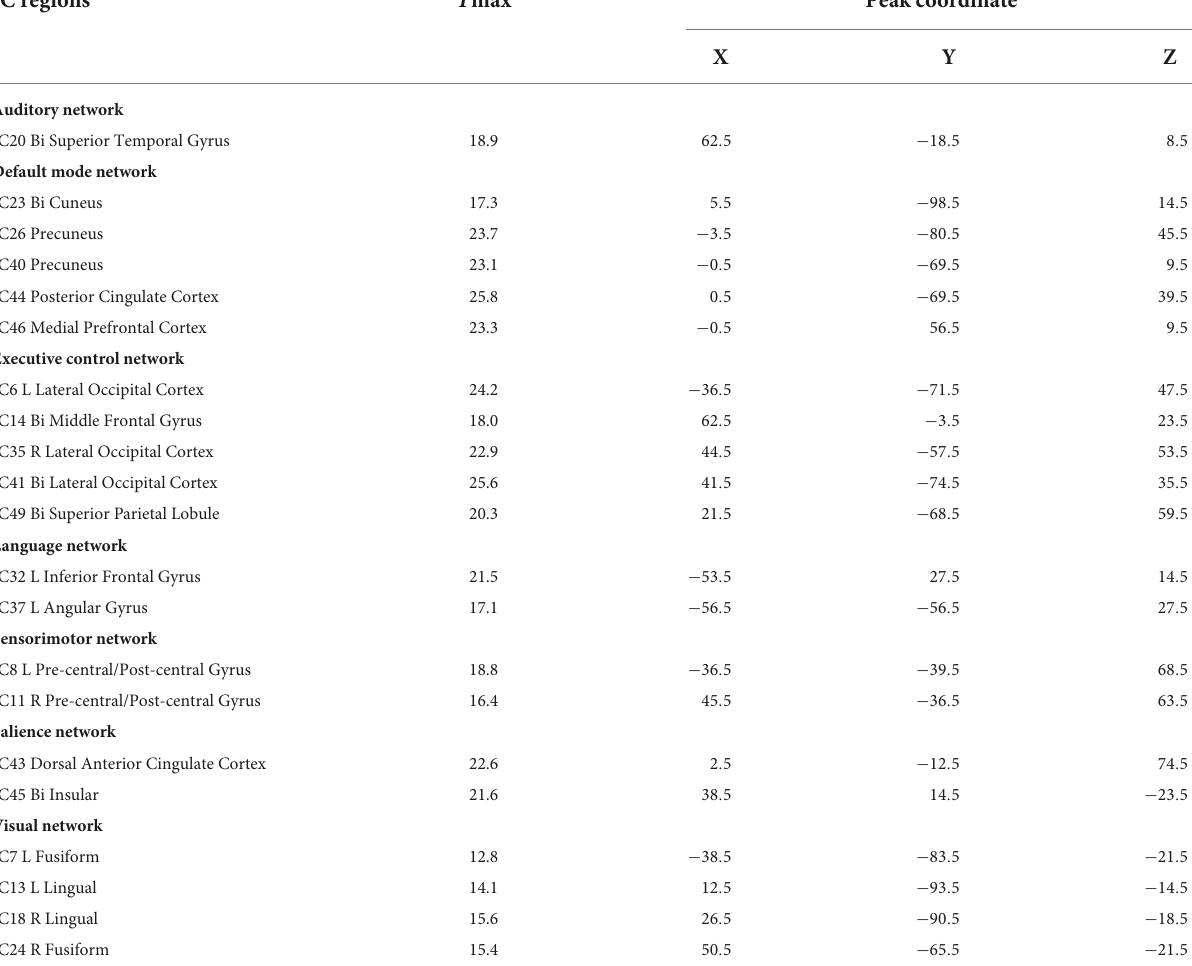
TABLE 1 Peak coordinates of the